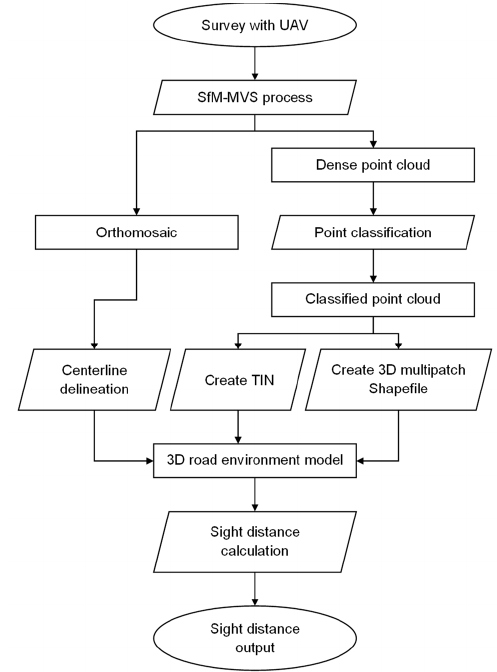
Figure 3. Procedure for creating the road environment model to calculate sight distance.